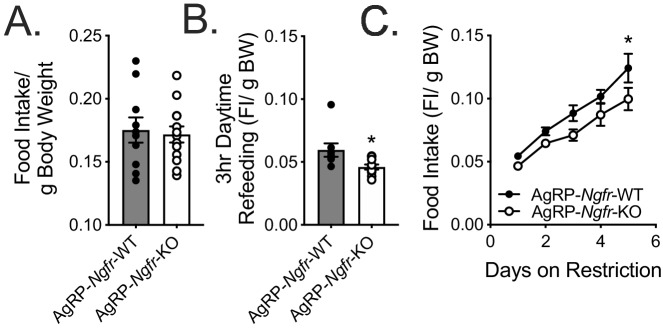
AgRP food intake normalized to total body weight.(A) Ad libitum food intake normalized to total body weight. Not significant by Student’s t-test. (B) Daytime refeeding normalized to overnight fasted body weight. *p=0.021 by Student’s t-test. (C) Daytime restricted food intake normalized to total starting body weight. *p=0.0427 (day 5), F(1,11)=4.675 by two-way repeated measures ANOVA with Bonferroni multiple comparisons; n = 6 WT, 7 KO.